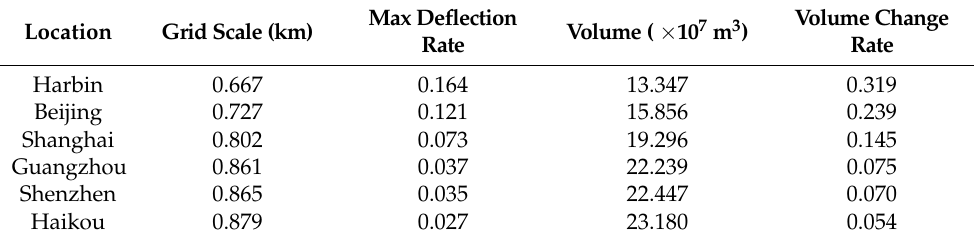
Table 6. Maximum deformation rate analysis.